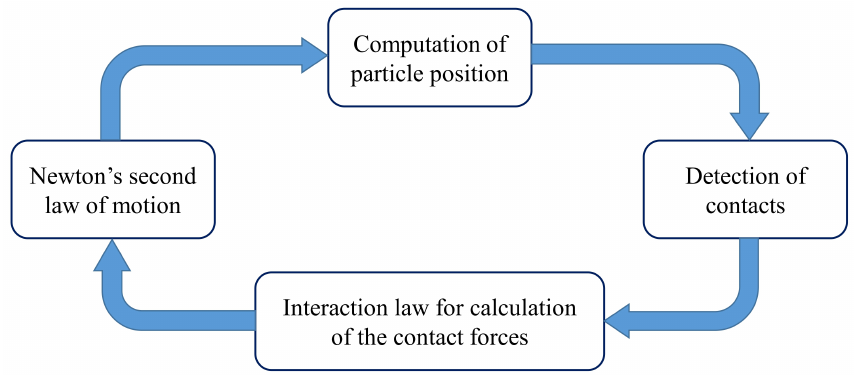
Figure 6. The computation cycle of a discrete element method (DEM)